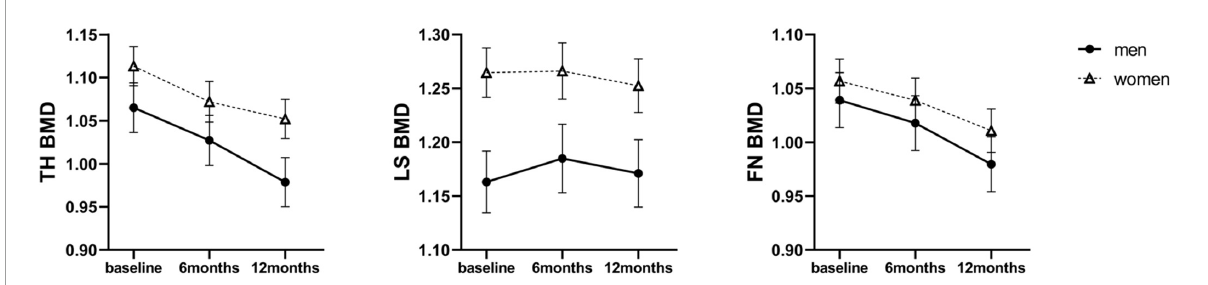
FIGURE1 Estimated marginal means (y-axis) of BMD for men and women group over time points (x-axis). Error bars indicate standard error. BMD, bone mineral density; TH, total hip; LS, lumbar spine; FN, femoral neck.